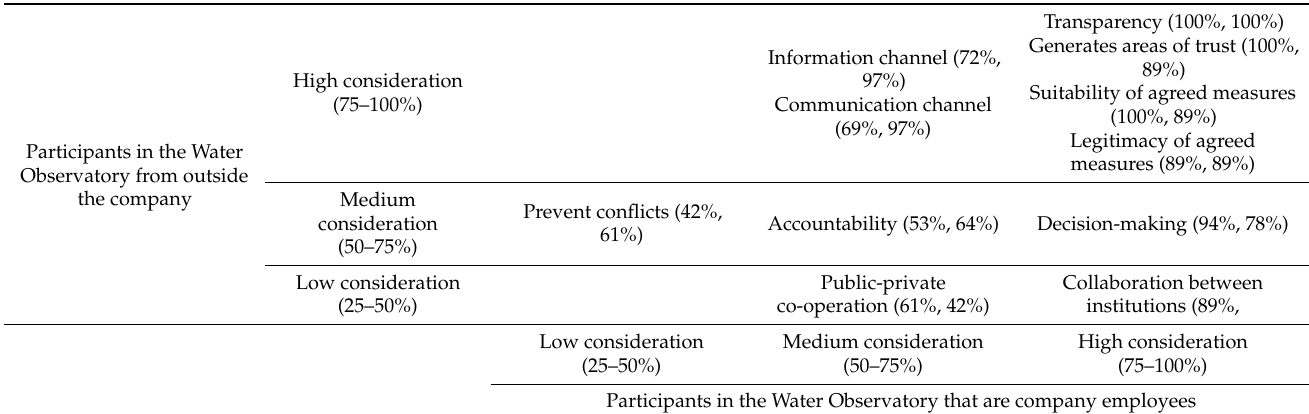
Table 3. Evaluation of usefulness of the Water Observatory. External participant % rating and employee % rating.